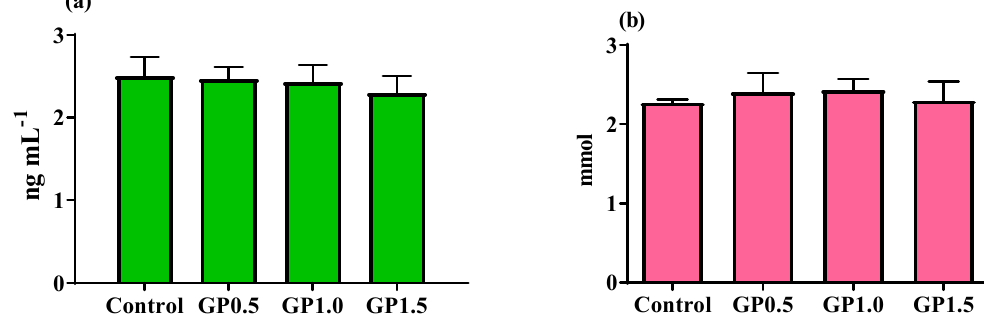
Table 6. Biochemical parameters in blood serum of Japanese quail fed diets with ginger powder supplementation. Treatments Ginger (0.5 g/kg of diet) Ginger (1.5 g/kg of diet)